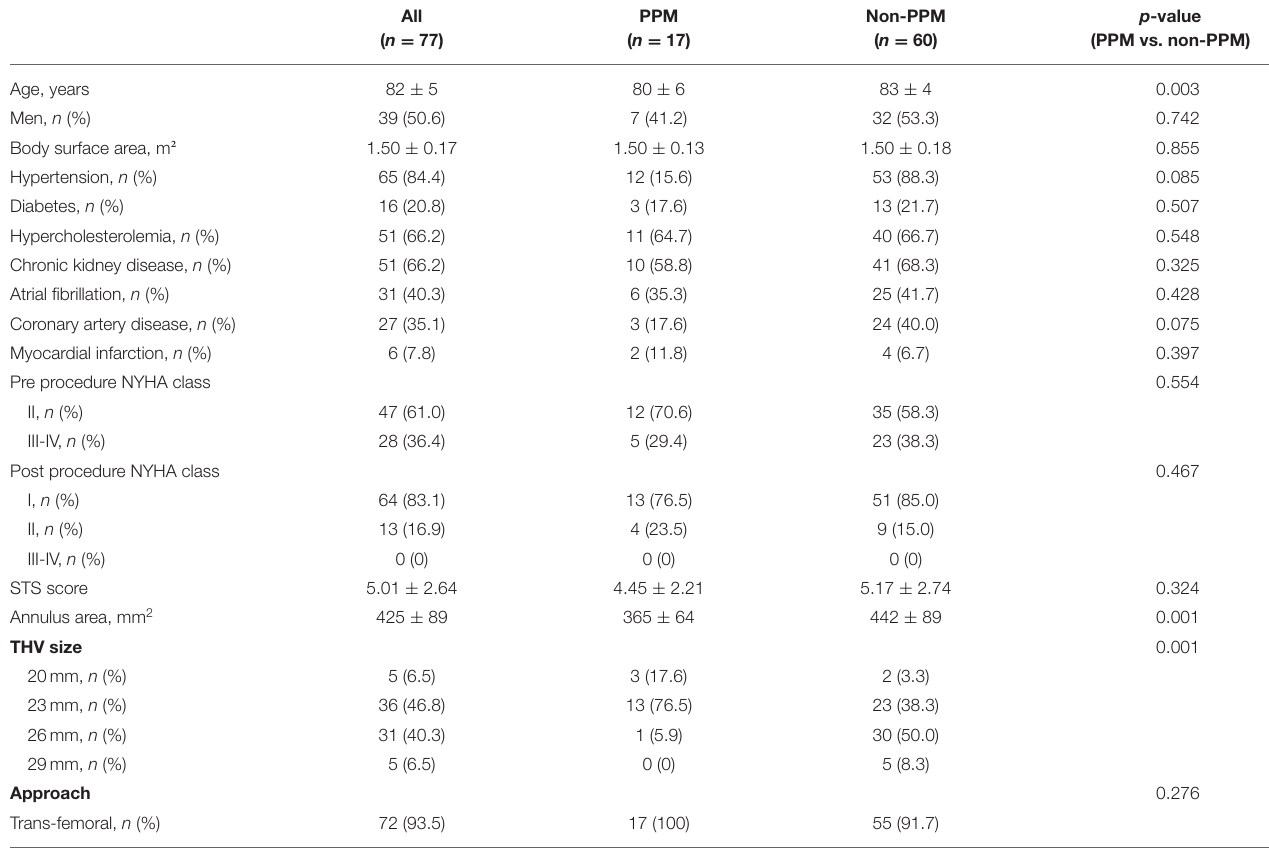
TABLE 1 | Procedural results and baseline